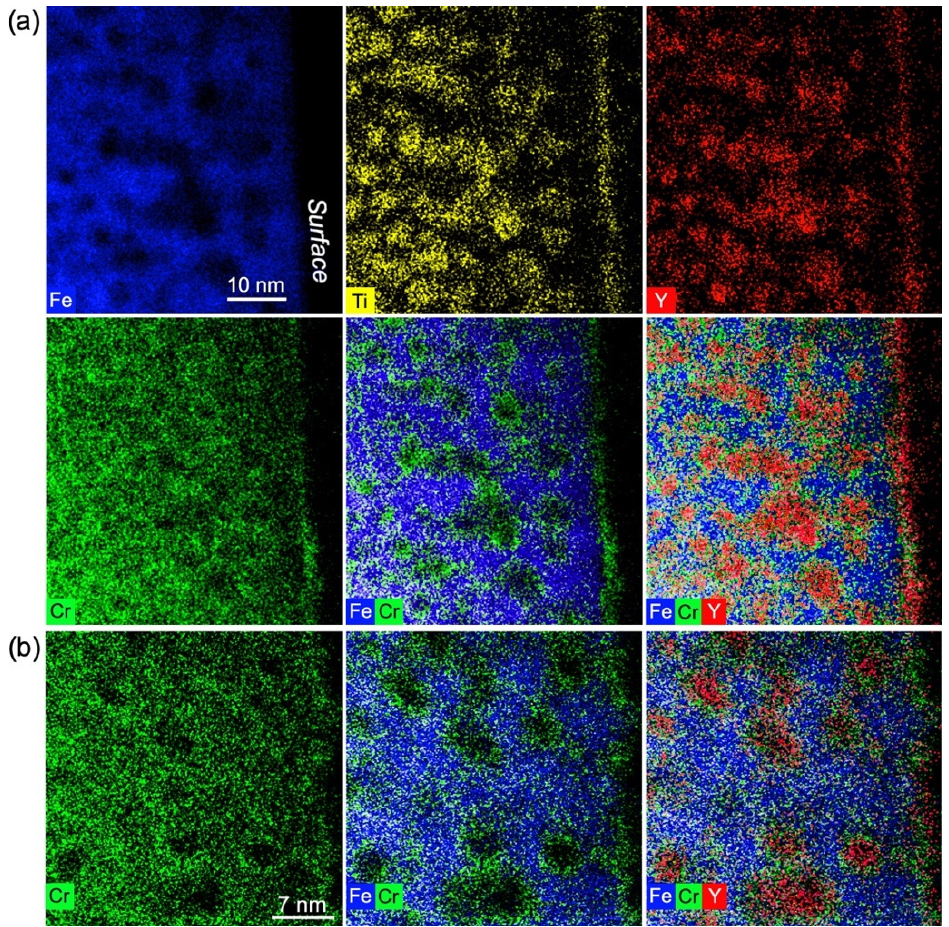
Figure 9. STEM-EDX imaging of precipitates synthesized by Y → Ti → O ion implantation into FeCr, subsequently annealed at 1100 °C for two hours. Two different areas are represented with different magnifications in ( a , b ).